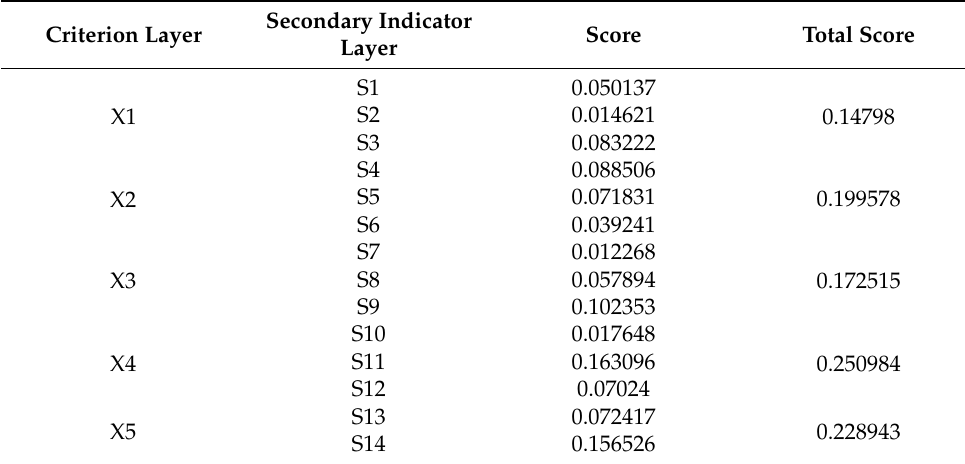
Figure 6. Analytical Network Process model. Table 6. The index factor weights of the